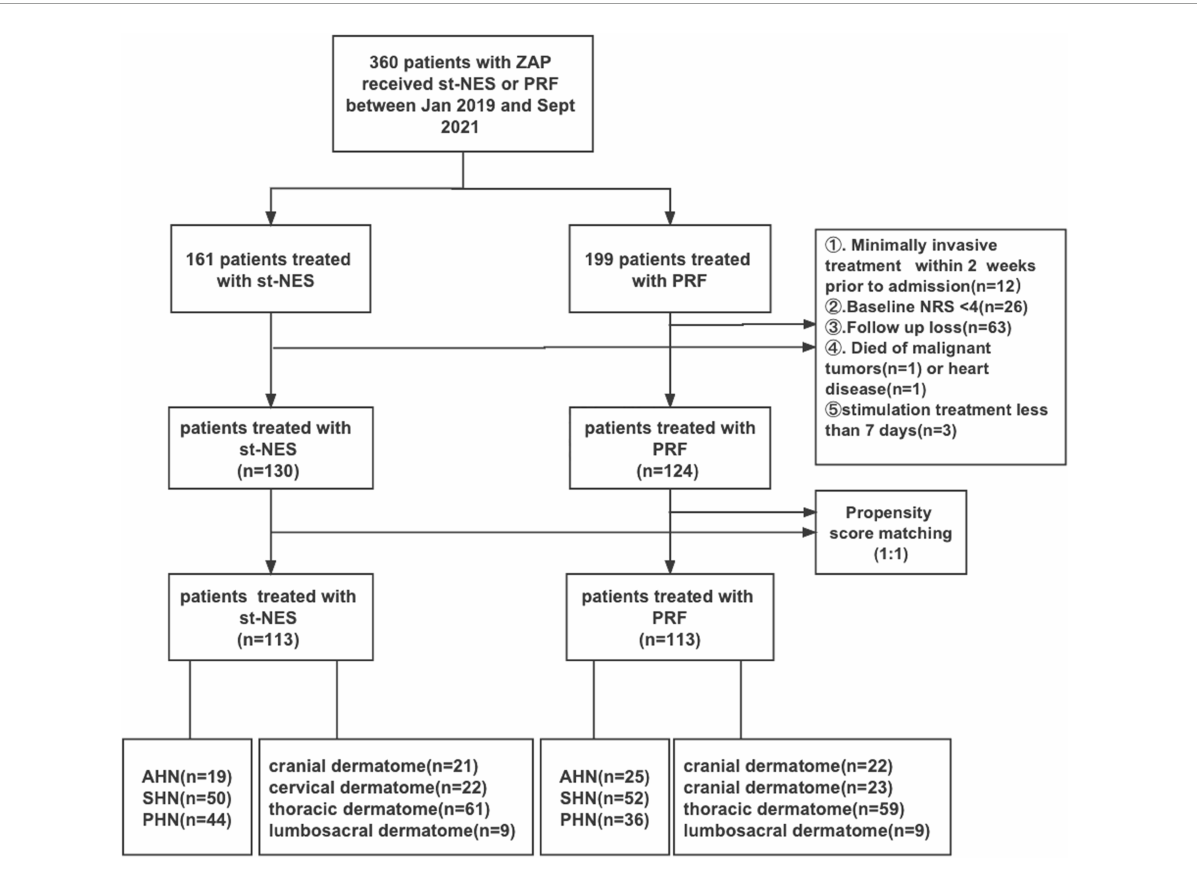
FIGURE1 Study design and